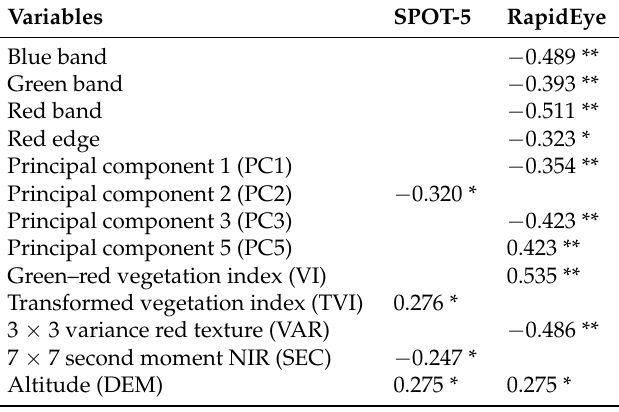
Table 4. Correlation coefficients for the linear regression of the AGB comparing with the variables (spectral reflectance, textures, vegetation index, and topographics) derived from SPOT5 and RapidEye